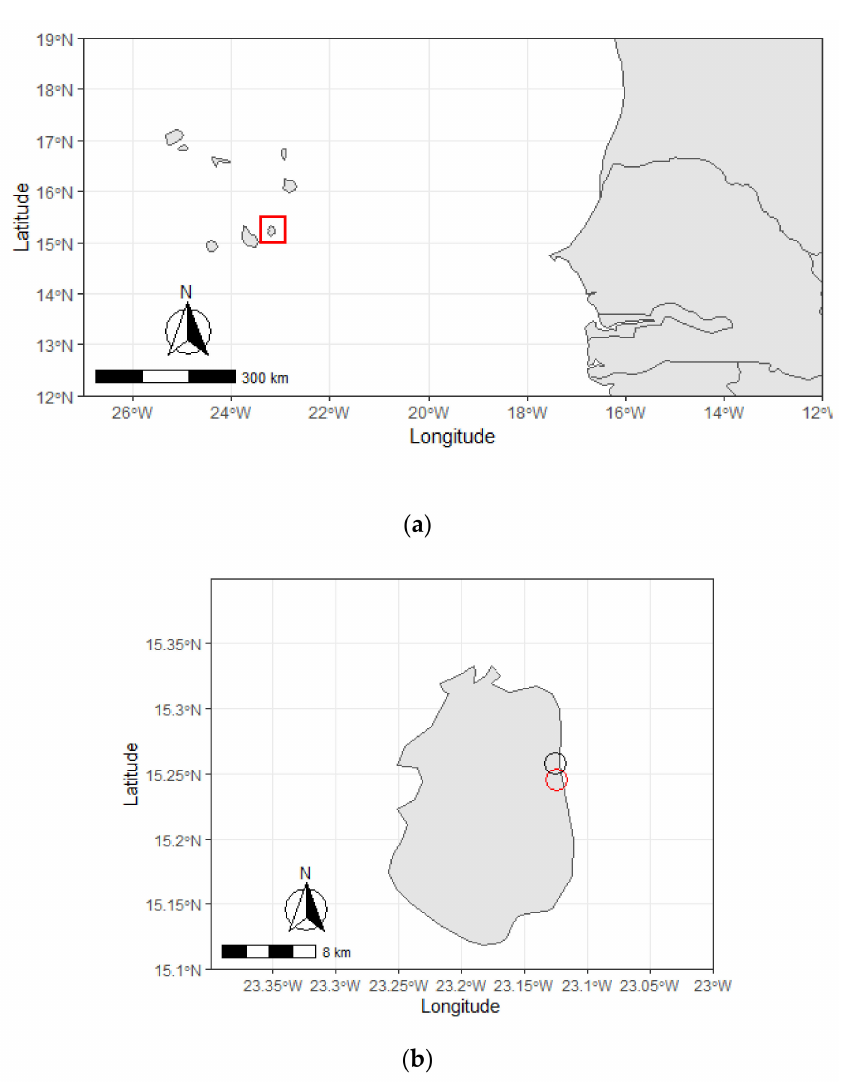
Figure 1. Area of study: (a) the archipelago of Cape Verde (15 ◦ 55 (cid:48) 0” N, 23 ◦ 55 (cid:48) 0” W), and the island of Maio (highlighted in red). (b) The island of Maio (15 ◦ 13 (cid:48) 50” N 23 ◦ 09 (cid:48) 22” W) and sampling points: “Praia Gonçalo” (15 ◦ 15 (cid:48) 25.9” N 23 ◦ 06 (cid:48) 34.5” W) (black circle) and “Pedro Vaz” (15 ◦ 14 (cid:48) 52.2” N 23 ◦ 06 (cid:48) 54.5” W) (red circle). Map created using R package “rnaturalearth” version 0.1.0 [39] and “ggplot2” version 3.3.3 [40] in R-Studio (Version; version